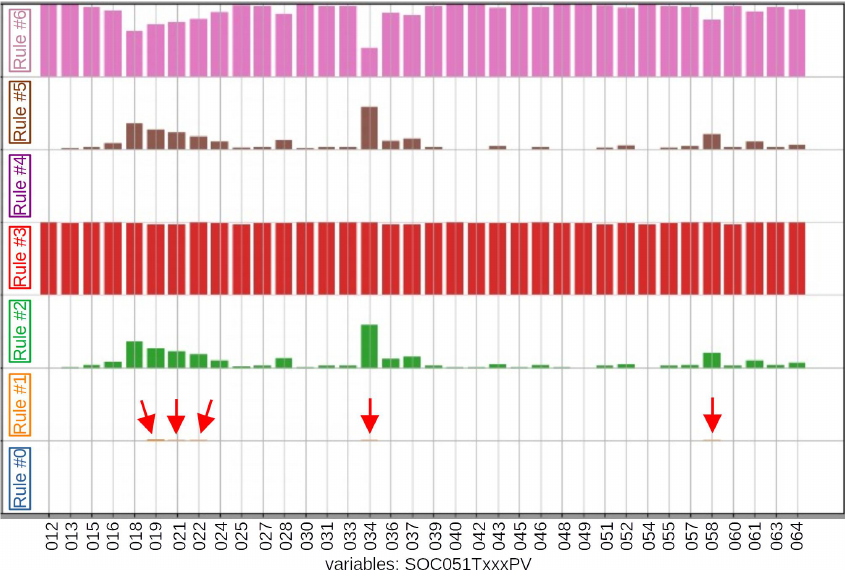
Figure 6. Bar graph of the cylinders subsystem between 17 July 2019 and 31 July